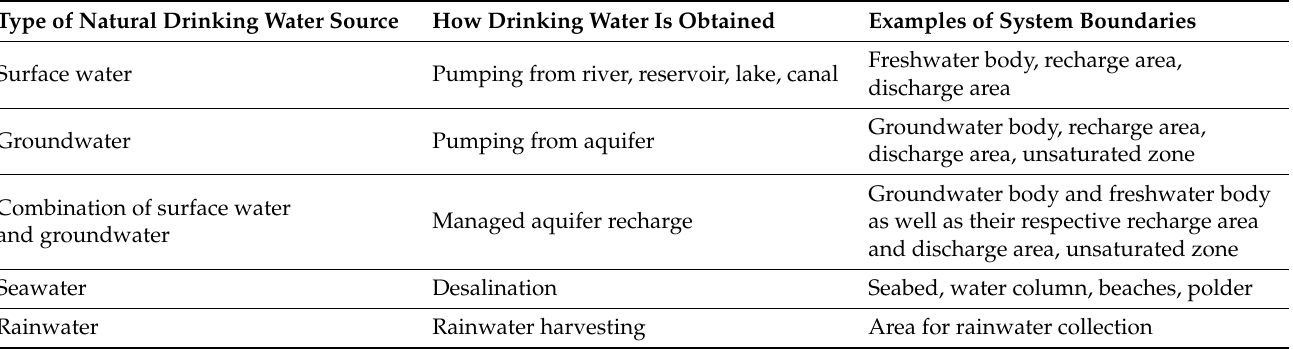
Table 2. Overview of types of natural drinking water sources. In what manner the water is obtained from each source indicates the system boundaries. The list is exemplary and not